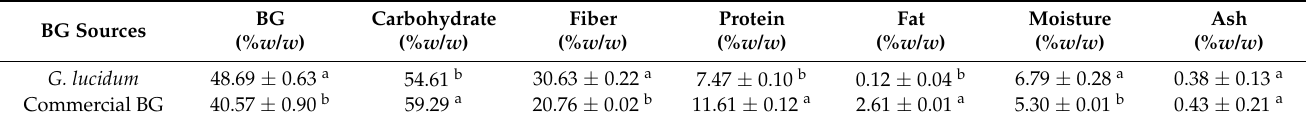
Table 1. Composition of commercially available G. lucidum BG and antler-type G. lucidum BG extract. BG BG Sources (% w / w